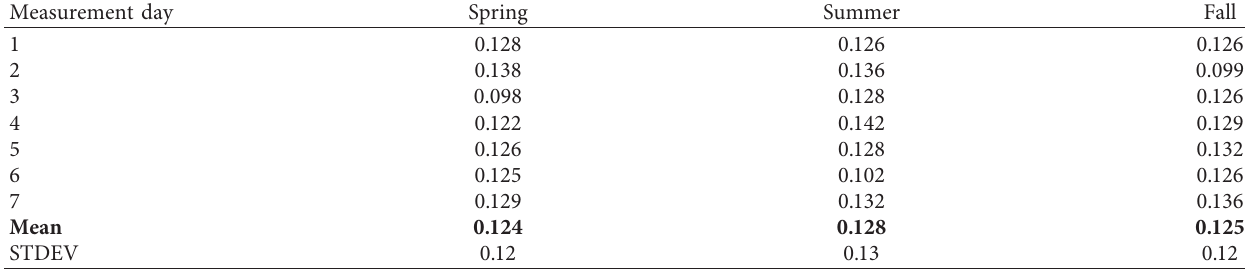
Table 1: Measured PFOA concentration ( μ g/L) from drinking water in Vienna (West Virginia) in 2016.